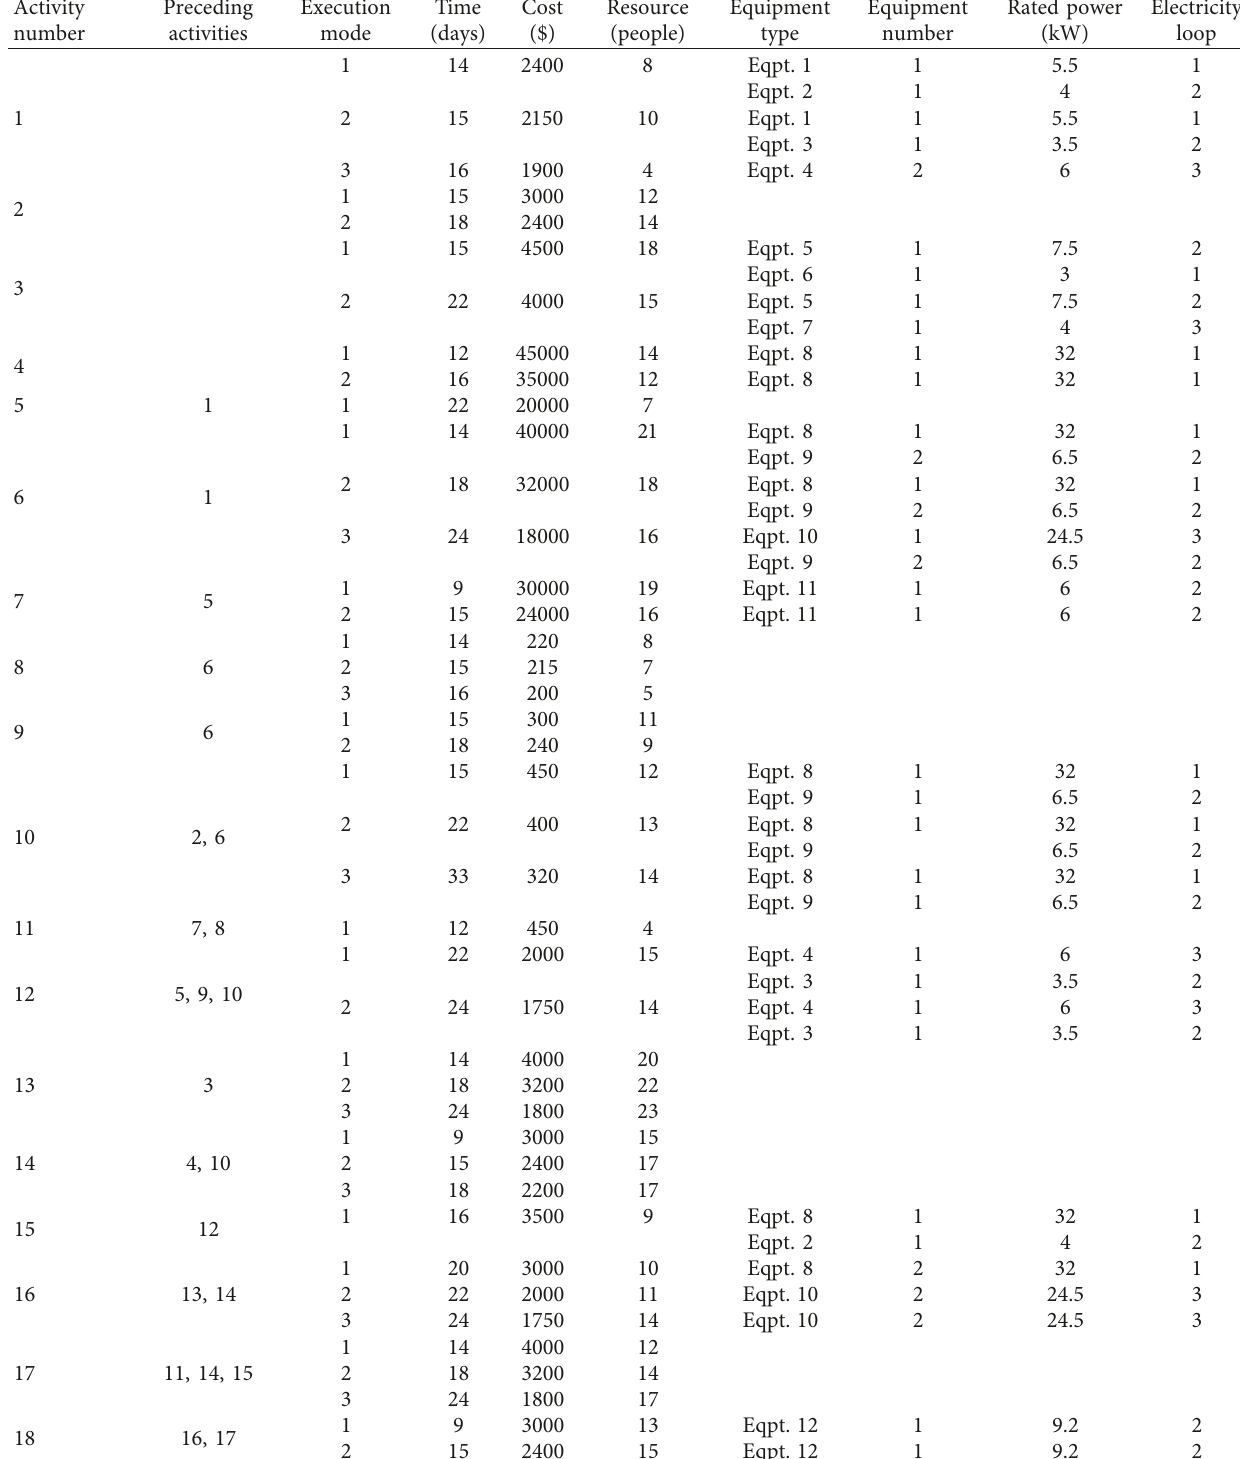
Table 3: Activity data of case